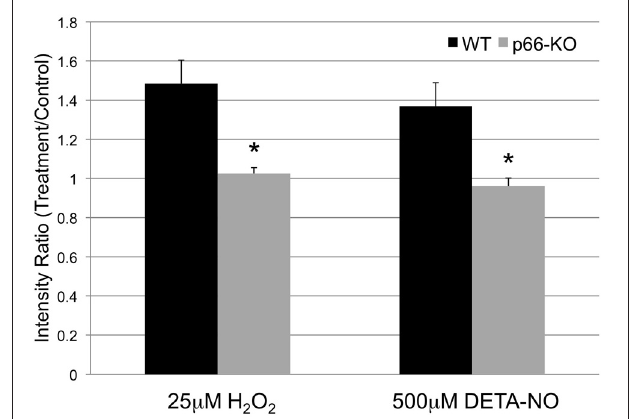
FIGURE 6 | p66-KO neurons generate less ROS following exposure to oxidative stress. Week-old p66-KO and WT neurons were treated with either 25 μ M H 2 O 2 , 500 μ M DETA-NO, or control media for 1h, and assessed for changes in mitochondrial ROS levels. Mitochondria were visualized with mito-GFP labeling, and mitochondrial ROS was visualized following Mitosox (a fluorescent reporter of mitochondrial superoxide) incubation. Following H 2 O 2 treatment, p66-KO neurons showed significantly less increases in mitochondrial ROS levels compared to WT neurons (p66-KO = 1 . 03 ± 0 . 03X; WT = 1 . 48 ± 0 . 12X). Similarly, following DETA-NO treatment, p66-KO neurons showed significantly less increases in mitochondrial ROS levels compared to WT neurons (p66-KO = 0 . 96 ± 0 . 04X; WT = 1 . 37 ± 0 . 12X). ( ∗ = p < 0 . 05) ( n = 10